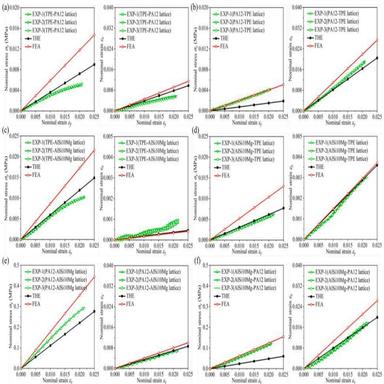
Theoretical, numerical and experimental results of the six kinds of bimaterial 3D DVH lattices, the nominal vertical stress σy - nominal vertical strain εy curves and nominal horizontal strain εx- nominal vertical strain εy curves of (a) (TPE, PA12), (b) (PA12, TPE), (c) (TPE, AlSi10Mg), (d) (AlSi10Mg, TPE), (e) (PA12, AlSi10Mg) and (f) (AlSi10Mg, PA12) concave 3D DVH lattices.